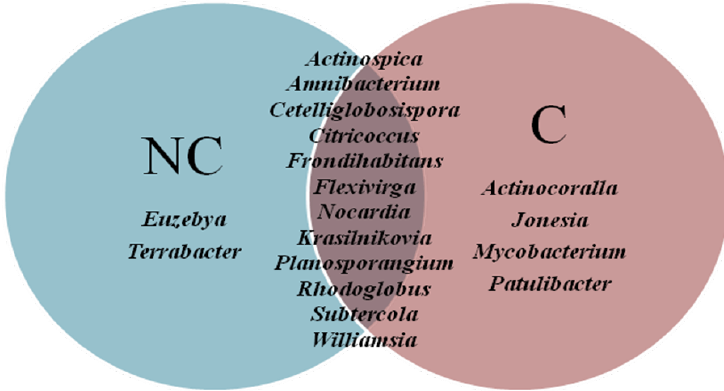
Figure 5. Beta-biodiversity of common and specific ActinobacteriaOTUs in NC and C soils from Lublin Region.